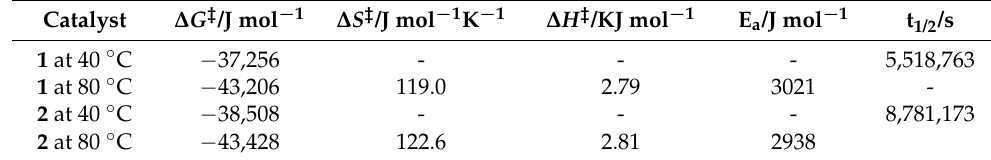
Table 5. Thermodynamics parameters for cyclohexanone oxidation over compounds 1 and 2 .